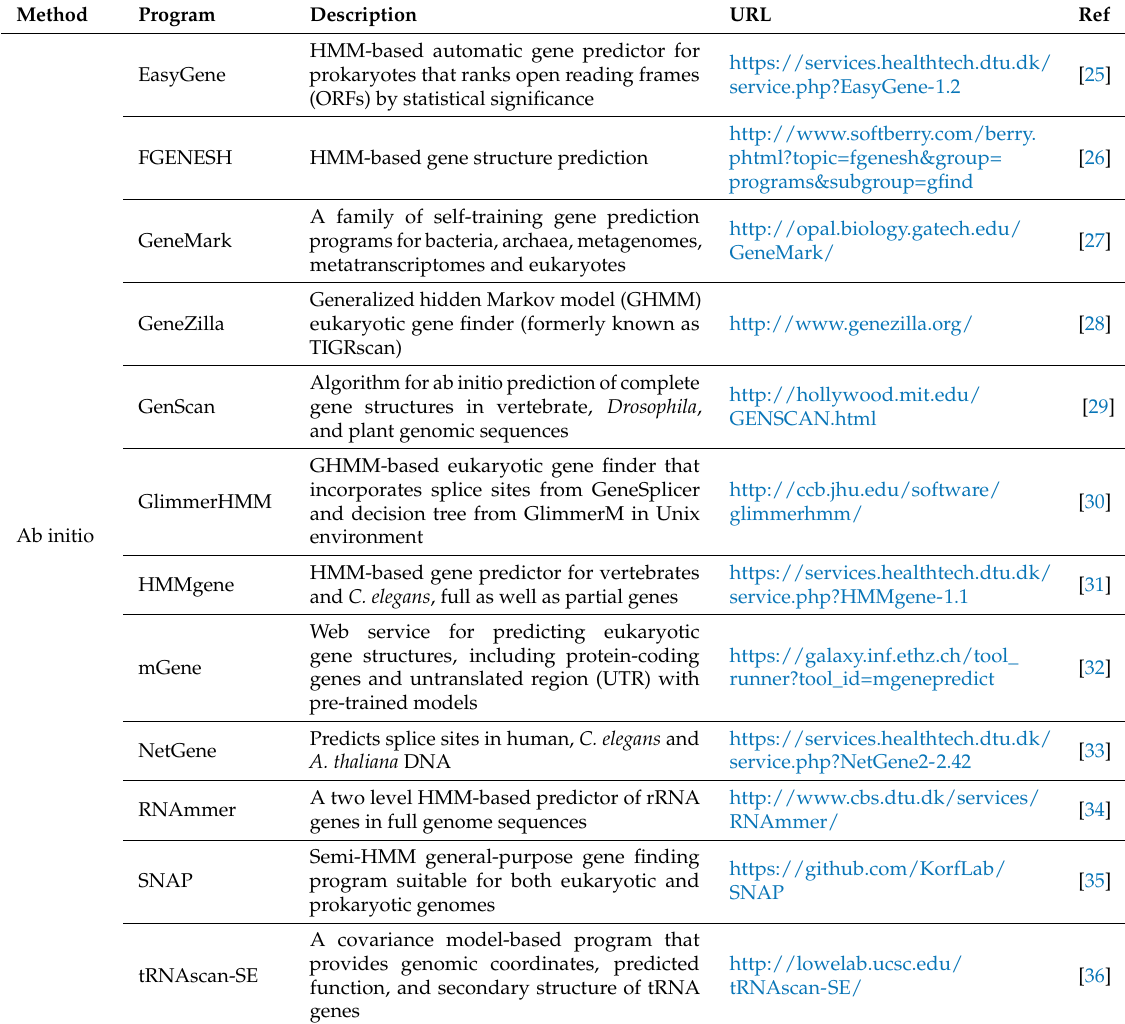
Table 1. Commonly used gene prediction